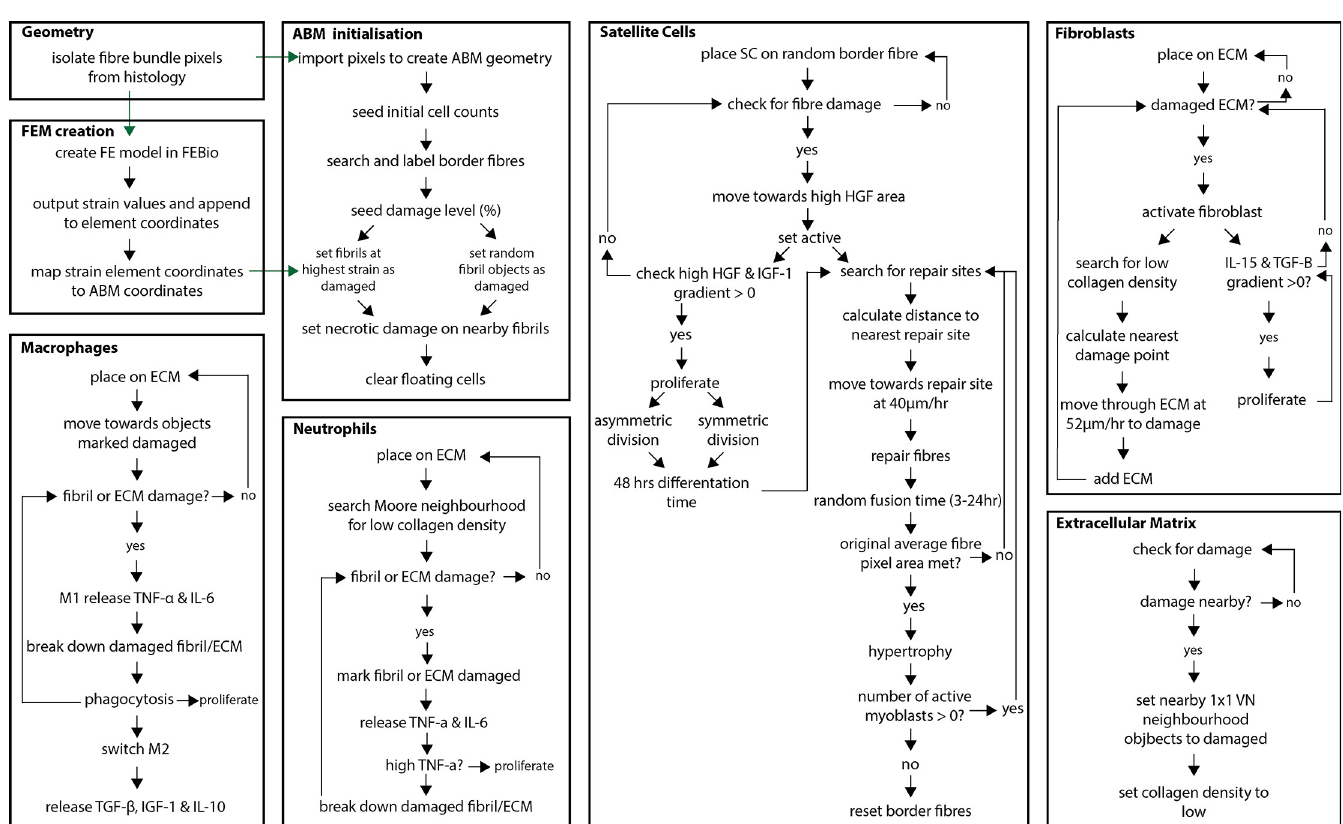
Fig 2. Flowchart of ABM agent behaviour. Green arrows indicate where data was imported to seed the ABM. Strain values from the FEM were taken in the case of localised damage, while random fibril objects were set to ‘damaged’ for the widespread damage simulations.